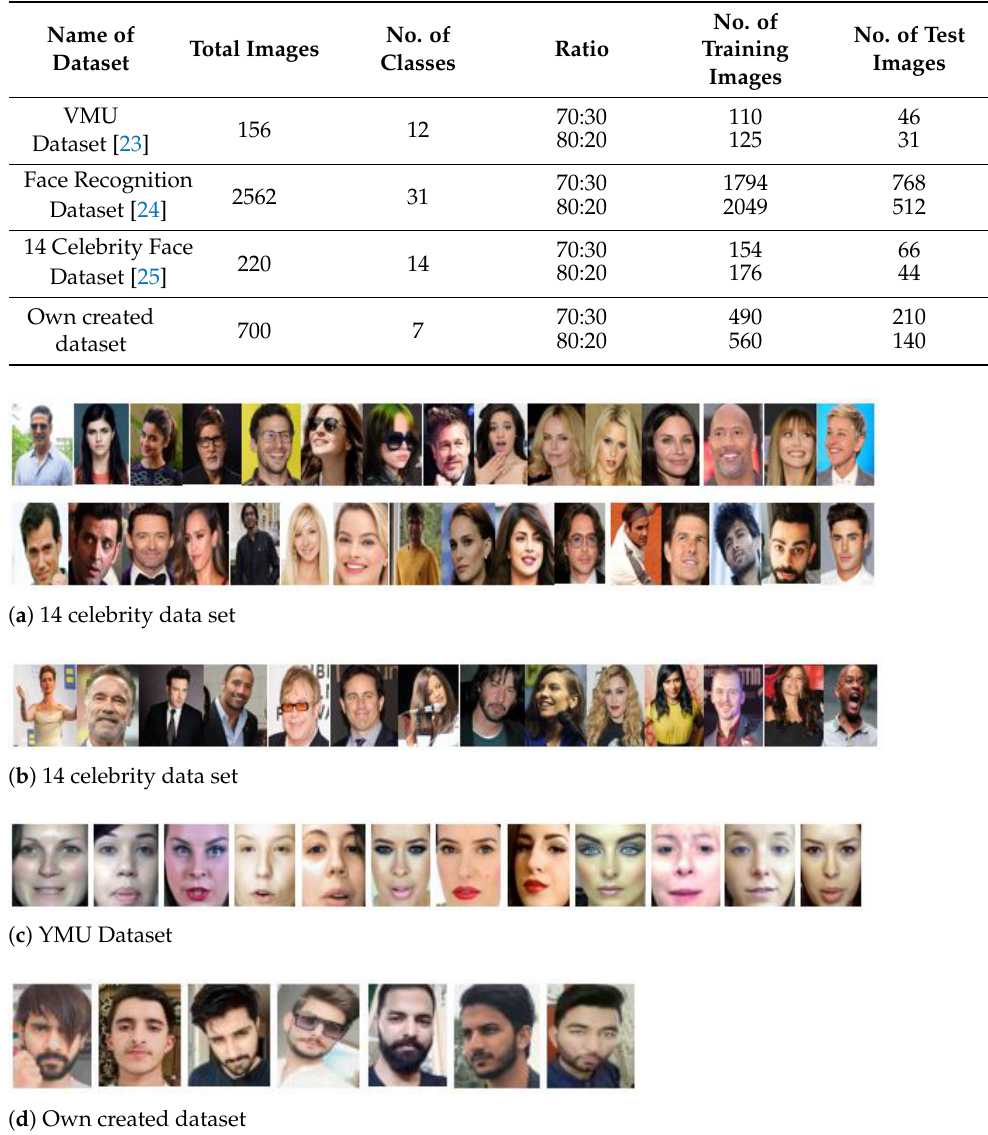
Figure 6. The photo gallery based on a random selection of images taken from each